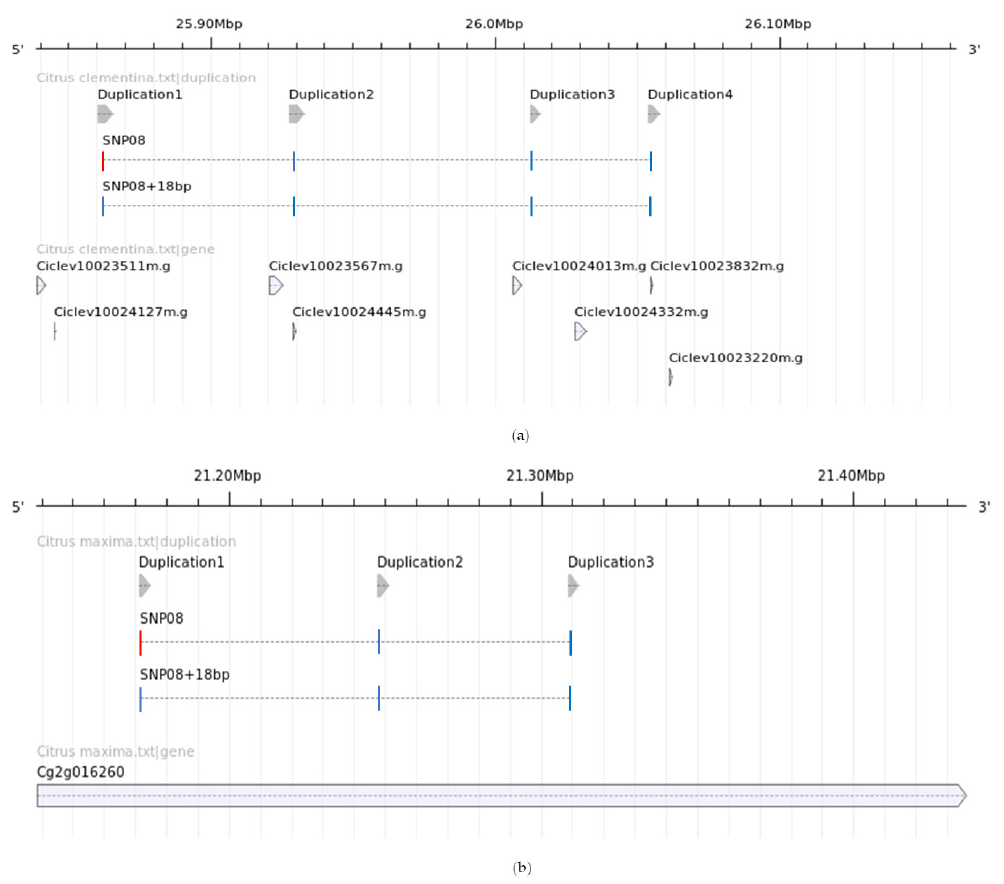
Figure 3. Duplicated regions flanking the SNP08 locus in Citrus clementina ( a ) and C. maxima ( b ) genomes. Duplication 1 in the clementine genome contains the mapped SNP08 at position 25862085 (in red), as indicated by Cuenca et al. [5]. ( a ) Scaffold 3 (25860390 to 25865701) in the C. clementina